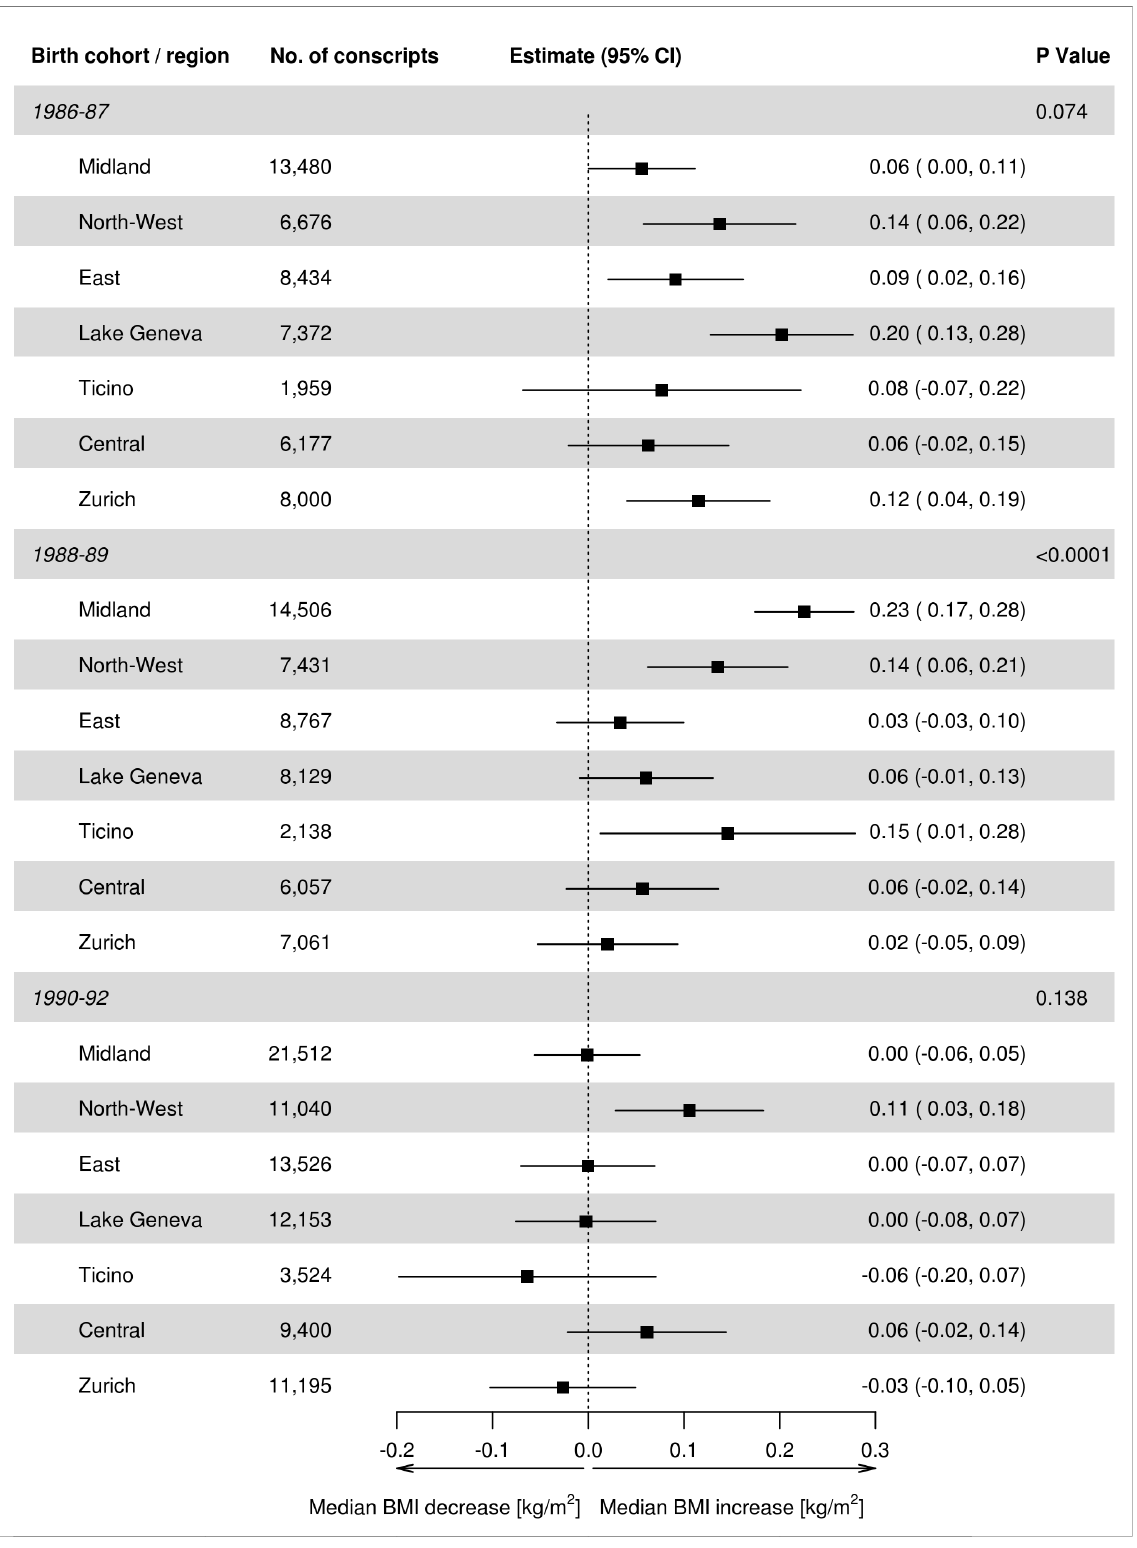
Figure 3. Annual change in median BMI (95% confidence intervals) estimated from the second multivariable quantile regression model of Swiss conscripts across birth cohort and region of residence. Model adjusted for professional status, tertile of median Swiss-SEP index of postcode of residence, degree of urbanicity of community of residence and linear splines for birth-year period and interaction of region with birth-year period.